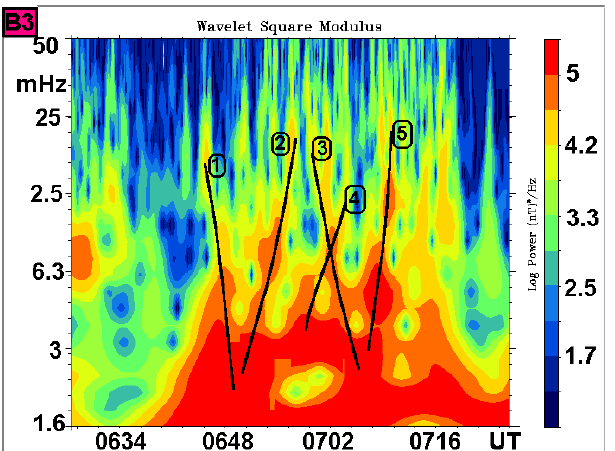
Plate B4. Wavelet correlation time for SM B z from Polar in the TBL (see Plates B1 and B3). Label ‘A’ stands for the coherent structure depicted in Plate B3. Figure 1: the same for Interball-1 GSM B y (see text for further